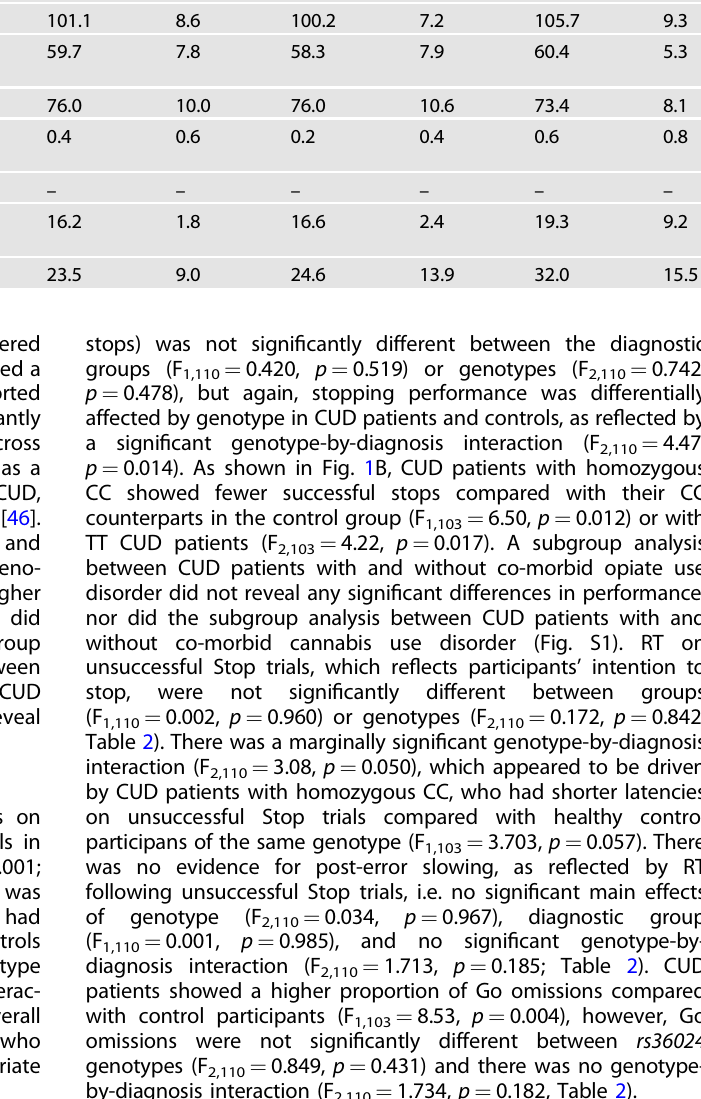
Table 2). There was a marginally signi fi cant genotype-by-diagnosis interaction (F 2,110 = 3.08, p = 0.050), which appeared to be driven by CUD patients with homozygous CC, who had shorter latencies on unsuccessful Stop trials compared with healthy control participans of the same genotype (F 1,103 = 3.703, p = 0.057). There was no evidence for post-error slowing, as re fl ected by RT